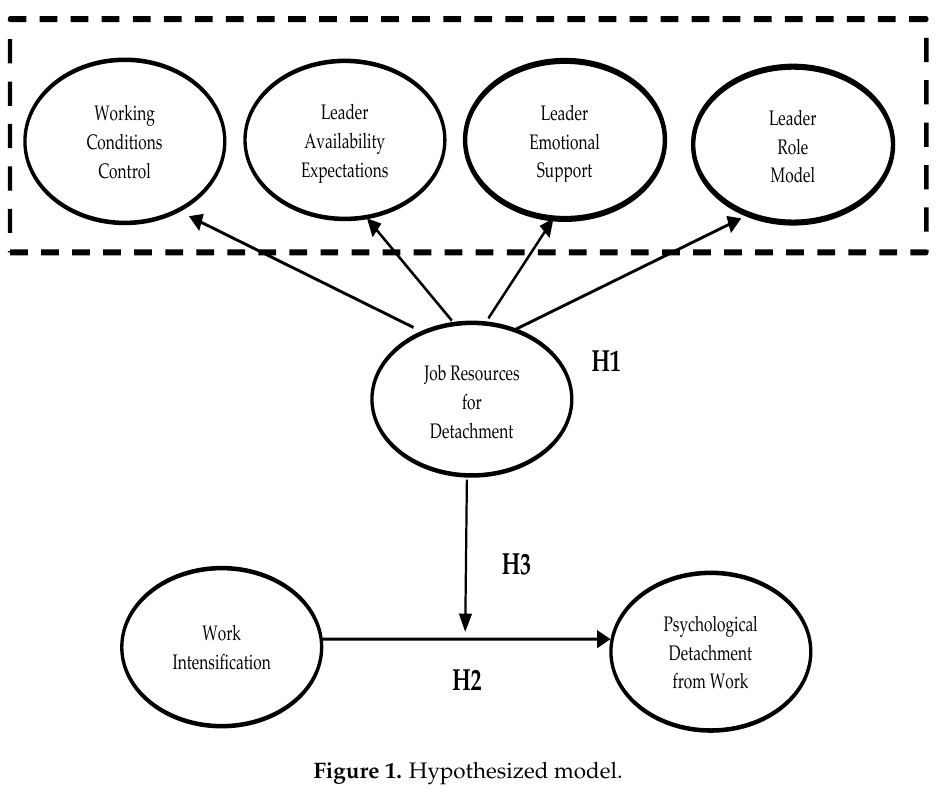
Figure 1. Hypothesized model.